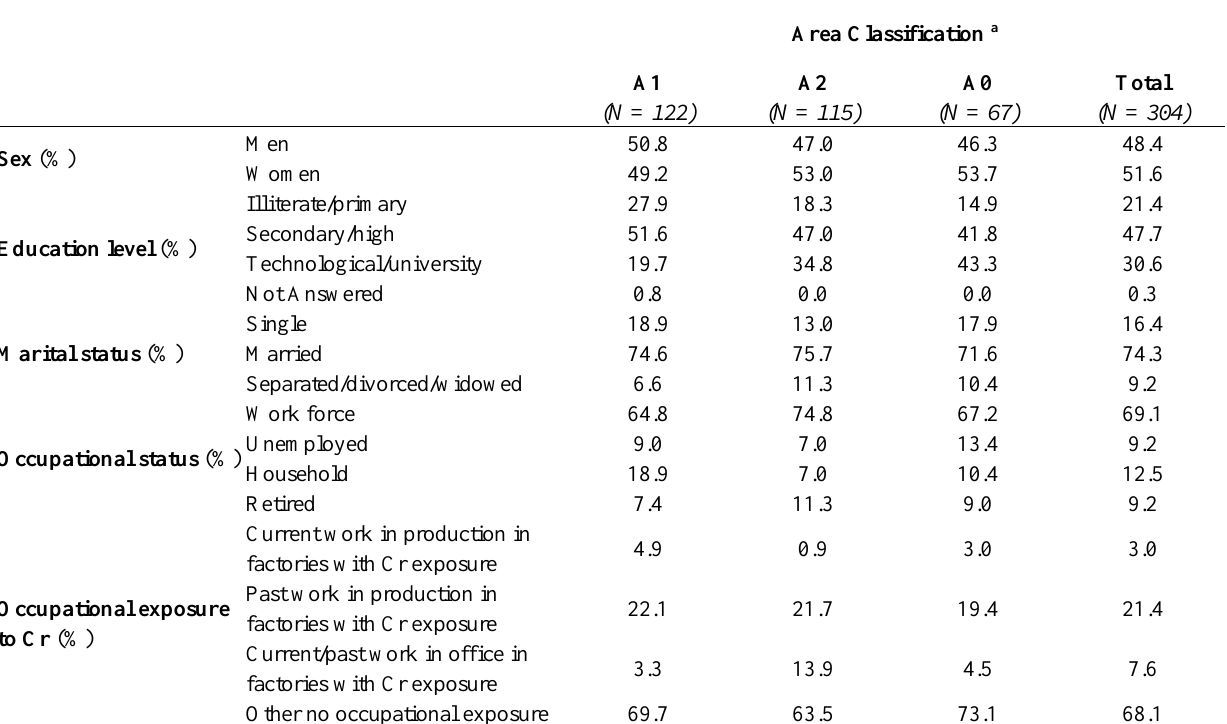
Table 2. Description of the study